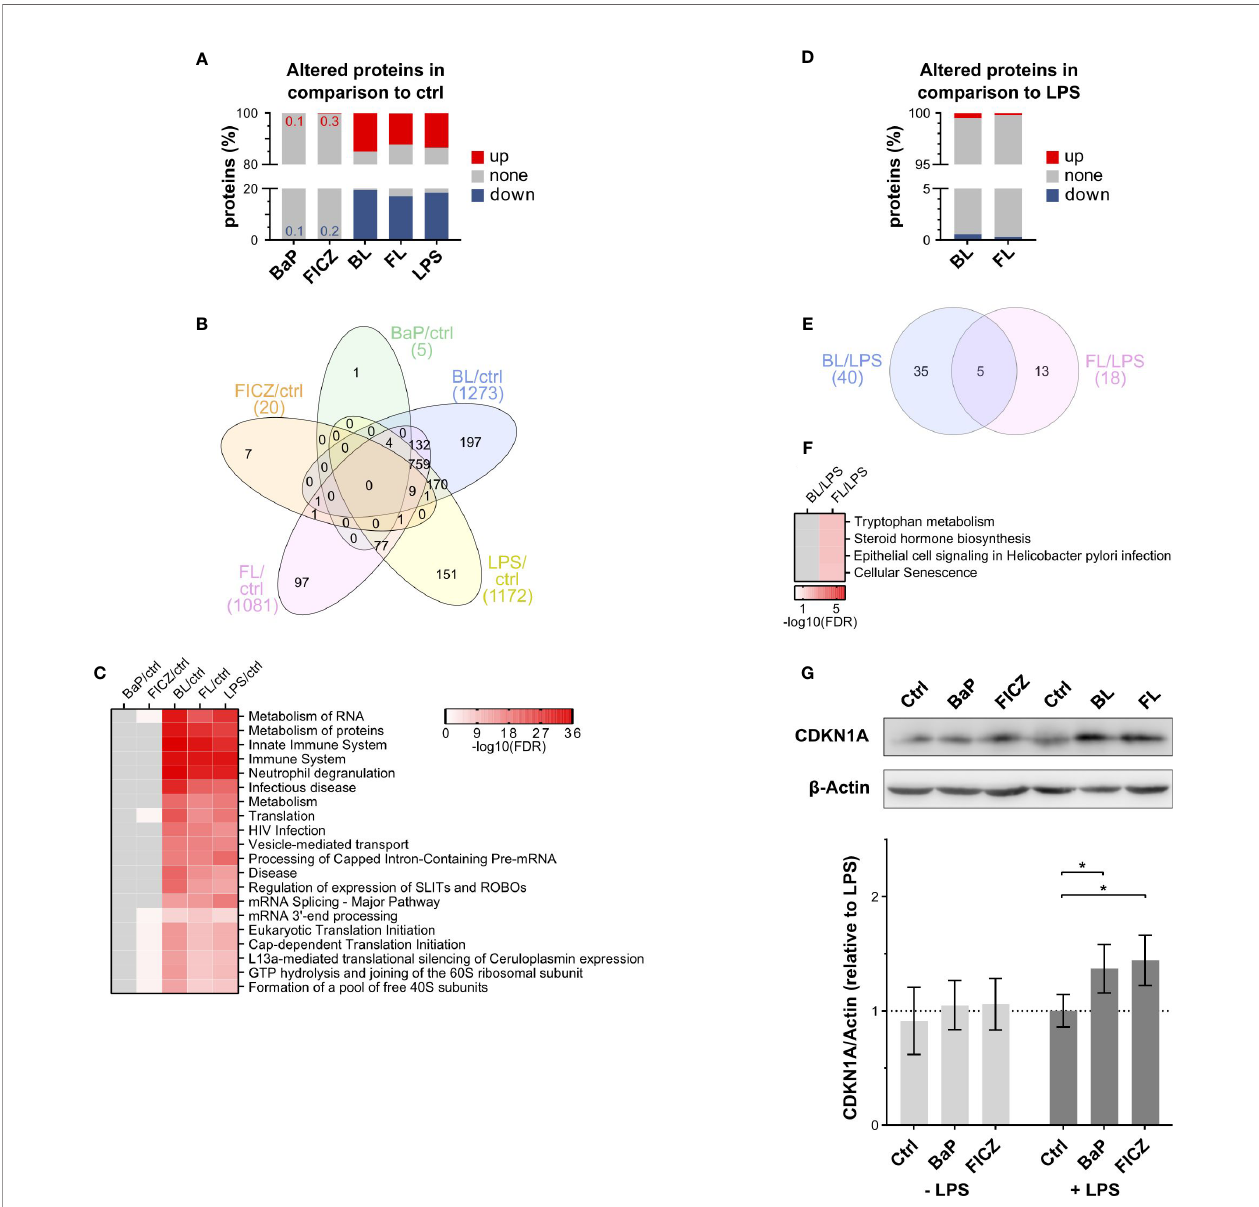
FIGURE 2 | Proteomic analysis of AhR-ligand treated macrophages in the presence/absence of LPS. (A) Percentage of signi fi cantly altered proteins after 2h compared to DMSO (ctrl). Proteins were considered as signi fi cantly altered compared to the control with a p-value ≤ 0.01, as determined by Student ’ s t-test (n = 7). (B) Overlap of altered proteins between treatments. (C) Pathways enriched among regulated proteins compared to the unstimulated control. Pathway enrichment analysis was conducted using the DAVID bioinformatics resources against KEGG and Reactome reference databases. Shown are the top 10 pathways based on their false discovery rate (FDR) for each treatment. (D) Percentage of signi fi cantly altered proteins in ligand- and LPS-stimulated cells in comparison to LPS alone (p-value ≤ 0.01, n = 7). (E) Overlap of proteins altered by AhR-ligands under in fl ammatory conditions. (F) Pathways enriched among regulated proteins in BL- and FL-treated cells compared to LPS-treatment. Shown are all signi fi cantly enriched pathways (FDR ≤ 0.05). (BL: BaP+LPS-treated; FL: FICZ+LPS-treated) (G) Relative CDKN1A protein levels were determined by western blot analysis. CDKN1A signal intensities were normalized to b -Actin. Shown is one representative blot out of 6 independent experiments and donors and normalized intensities relative to LPS-treatment ± SEM (n = 6). Signi fi cant changes were determined by two-sided, paired t-test (*p ≤